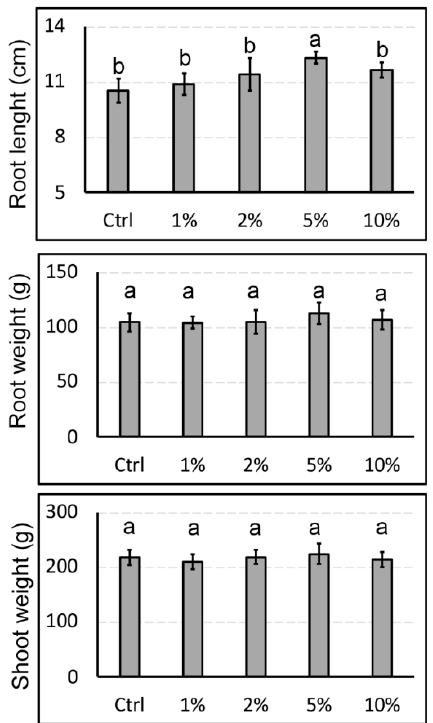
Figure 1. Effects of different APR® concentrations on the physiological growth parameters of Zea mays L. seedlings. The graphs represent the root length, the root weight and the shoot weight of maize seedlings hydroponically grown for three days at increasing concentrations of APR®. The values represented in the graphs were calculated from three independent experiments ( n = 10) and represent the mean ± the standard error. Significantly different values ( p < 0.05) are evidenced by different letters (One-way Anova, LSD post-hoc